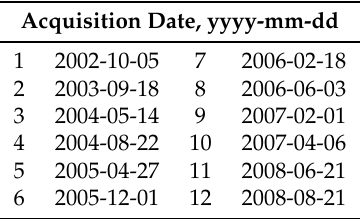
Table 1. Image acquisition dates for the SPOT-5 dataset.